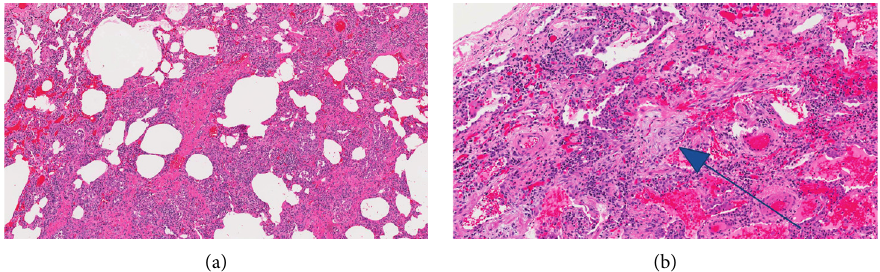
Figure 2: Surgical biopsy of the right lung (Case 1) demonstrates features of mixed cellular-fibrotic non-specific interstitial pneumonia (a) with scattered foci of organizing pneumonia (arrow)